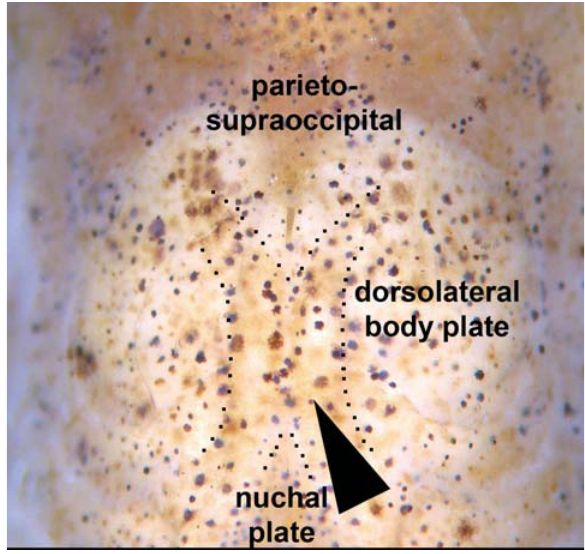
Fig. 2. Dorsal view of head of Aspidoras psammatides , holo- type, MNRJ 28407, 25.7 mm SL. Arrow: naked groove between parieto-supraoccipital posterior process and nuchal